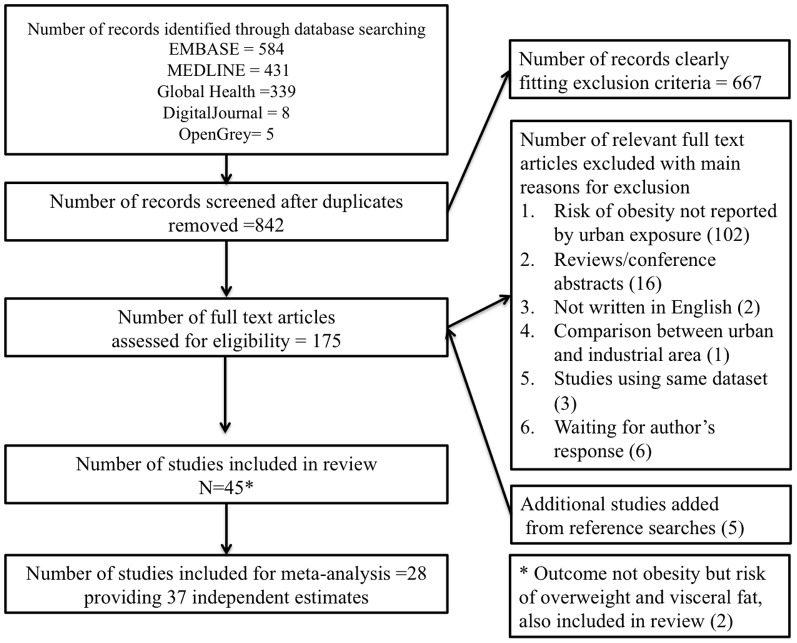
Flow chart of articles included in the review.